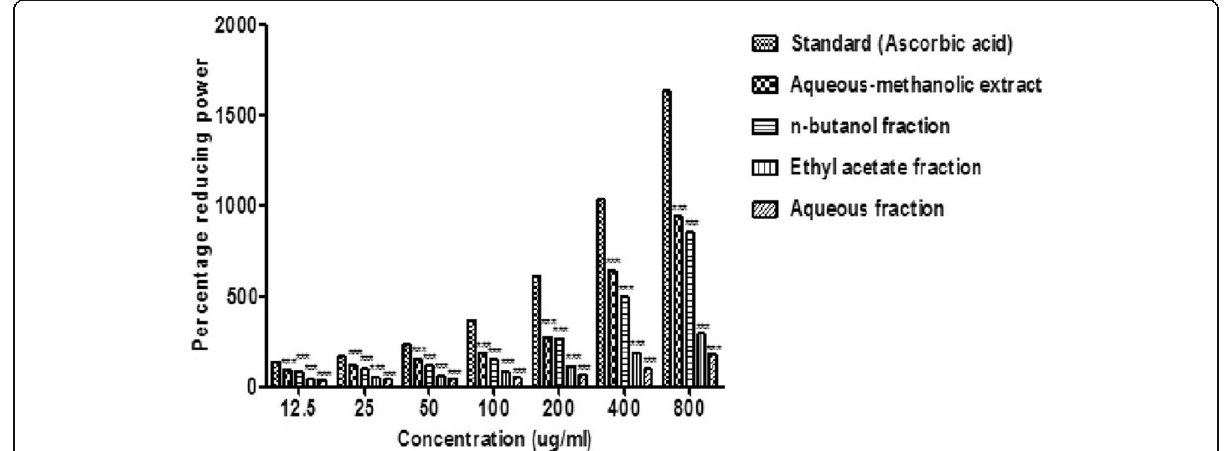
Table 6 Functional groups identified by FTIR spectroscopy in B.orthobotrys n -butanol fraction Peak Bond Functional group 3354.21 cm − 1 - OH Stretching vibrations Phenols 3334.92 cm − 1 2956.87 cm − 1 – CH Stretching vibrations 2872.01 cm − 1 alkanes 1722.43 cm − 1 C = 0 carboxylic acid stretching vibrations 1459.76 cm − 1 CH 3 bending vibrations Methyl C-F stretching vibrations Carbon